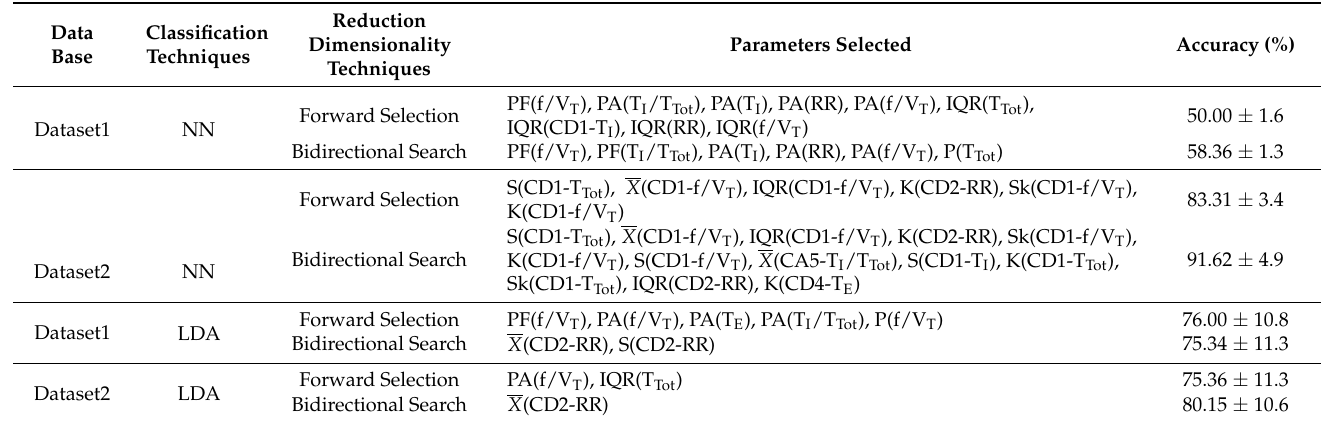
Table 5. Parameters with the highest accuracy (mean ± standard deviation), when comparing the groups of patients FG vs